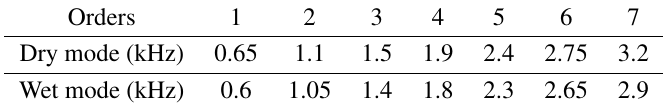
Table 1. Modes of dry and wet plate (below 4